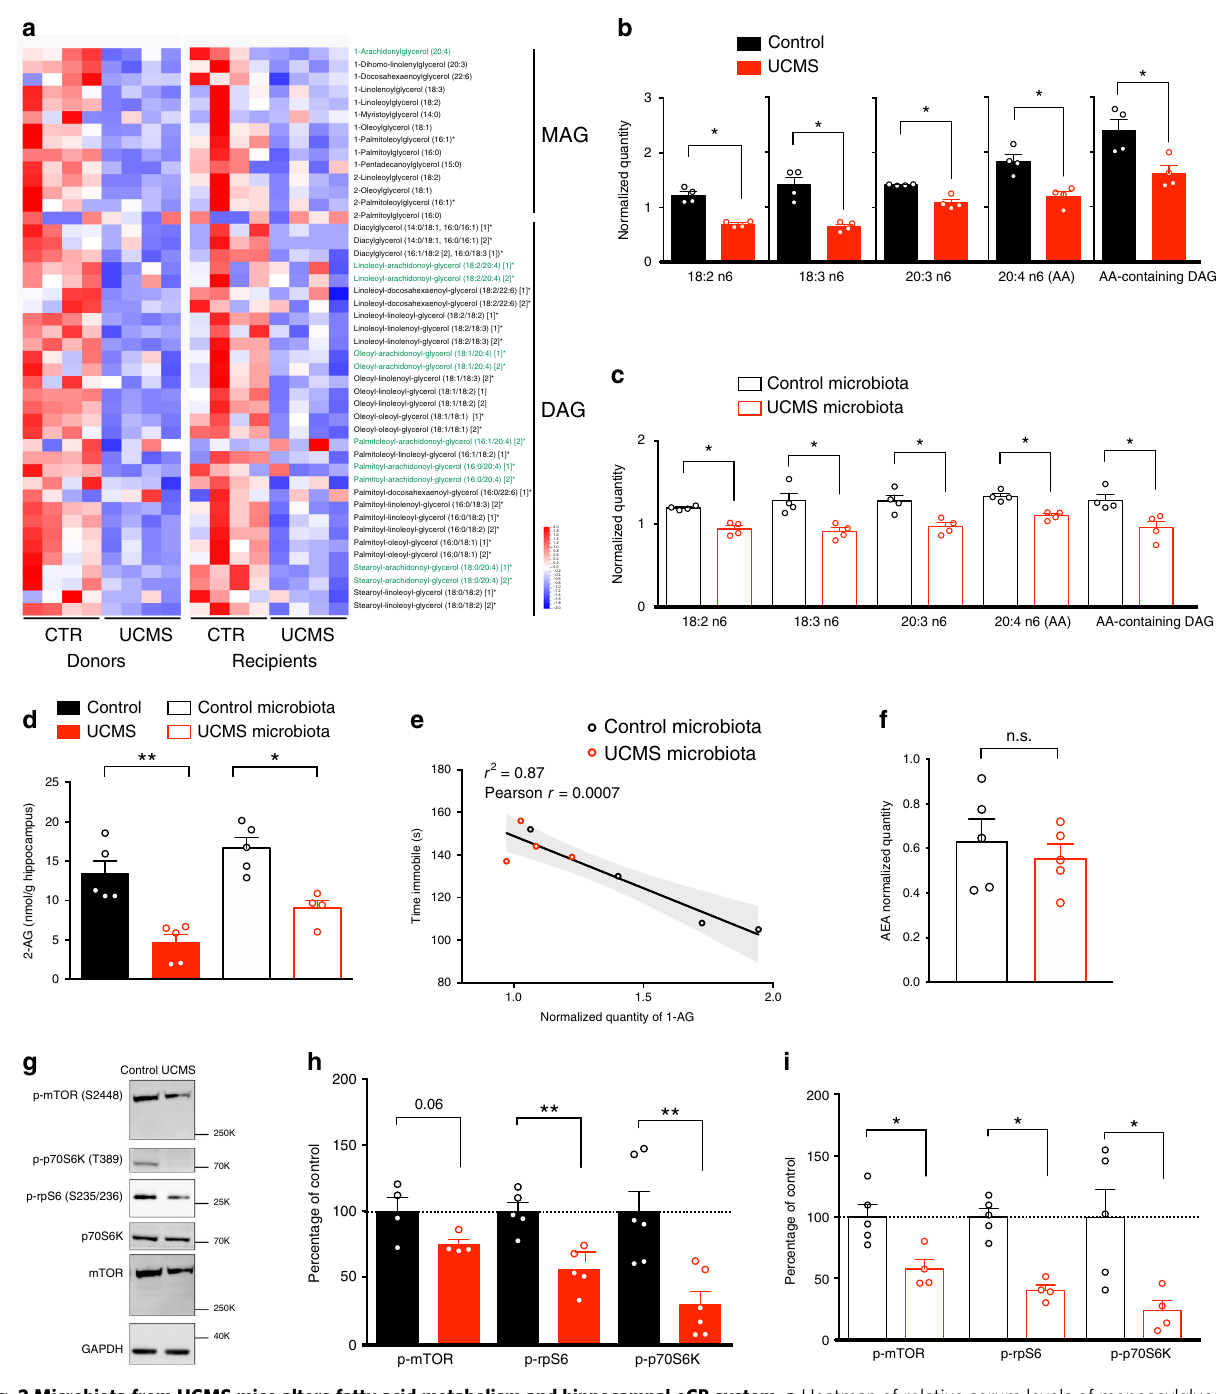
Fig. 2 Microbiota from UCMS mice alters fatty acid metabolism and hippocampal eCB system. a Heatmap of relative serum levels of monoacylglycerols (MAG) and diacylglycerols (DAG) in donor ( n = 4/group) and recipient mice ( n = 4/group) ( z -scored). Arachidonic acid-containing MAG and DAG are highlighted in green. b , c Relative levels of fatty acid in the synthesis pathway of arachidonic acid (AA) and AA-containing DAG in donor mice ( n = 4; b ) and in recipient mice ( n = 4, c ). For b , c , data are represented as mean ± s.e.m. Statistical signi fi cance was calculated using Mann – Whitney test (* P = 0.0286). d Concentration of 2-AG in the hippocampus of donor ( n = 5/group) and recipient mice ( n = 5/group) was determined by targeted LC-MS (Control vs UCMS, P = 0.0079; Control microbiota- vs UCMS microbiota-recipient mice, P = 0.0159). e Correlation between serum quantity of 1-AG and time spent immobile in the tail suspension test (TST) in recipient mice ( n = 4/group). Correlation was calculated using Pearson correlation factor r ( r = 0.0007). f Relative quantity of the endocannabinoid anandamide (AEA) in the hippocampus of recipient mice ( n = 5/group, P = 0.6905). g Representative western blots for p-mTOR (S2448), p-rpS6 (S235/236), p-p70S6K (T389), mTOR, p70, and GAPDH in hippocampal protein extracts from donor mice. h , i Quanti fi cation of the phosphorylation of mTOR, rpS6, and p70S6K in protein extracts from the hippocampus of Control and UCMS donor mice (p-mTOR, n = 4, P = 0.0571; p-rpS6, n = 5, P = 0.0079; p-p70S6K, n = 6, P = 0.0087; e ) and Control microbiota- ( n = 5) and UCMS microbiota-recipient mice ( n = 4) (p-mTOR, P = 0.0317; p-rpS6, P = 0.0159; p-p70S6K, P = 0.0317; f ). For b – d , f , h , i , data are represented as mean ± s.e.m. Statistical signi fi cance was calculated using Mann – Whitney test (* P < 0.05, ** P < 0.01, two tailed). Source data are provided as a Source data fi